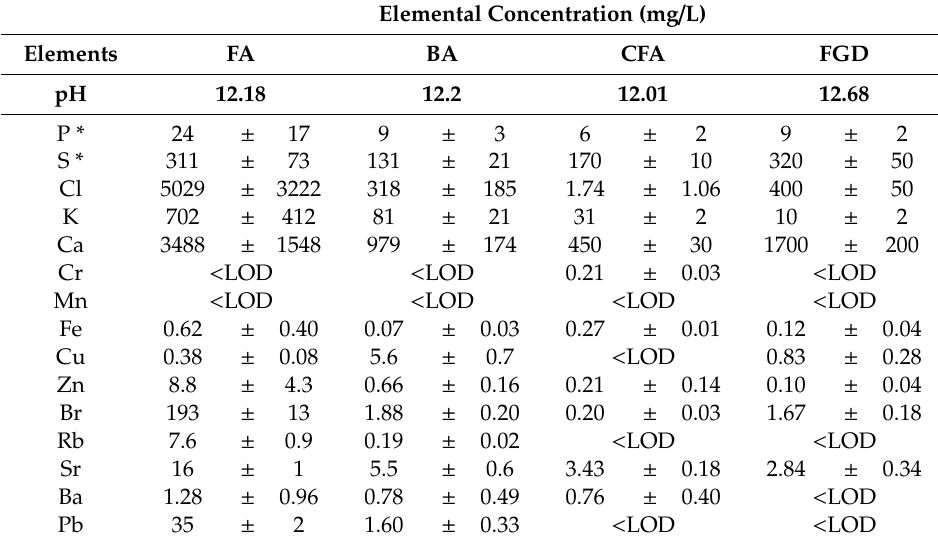
Table 1. Results of the total reflection X-ray Fluorescence (TXRF) analysis and pH values of leaching test of raw powders. Values are expressed as the average ± standard deviation of three TXRF measurements. Relative sensitivities for elements with * were calculated based on a calibration curve (see the experimental section). LOD—lower detection limit.